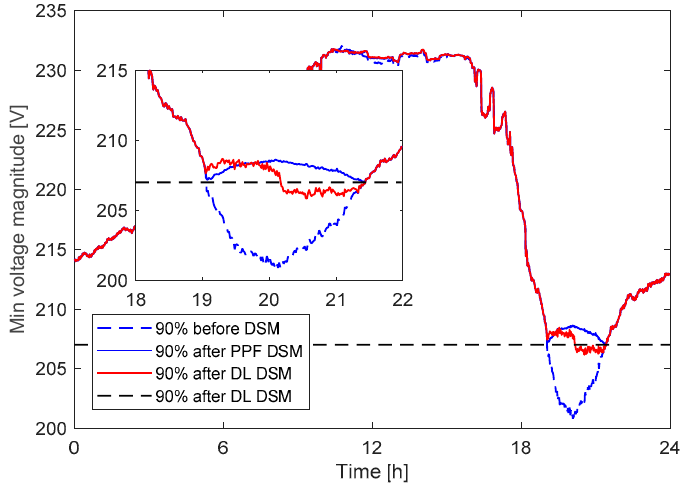
Figure 7. 90% probability minimum voltage magnitudes over time.